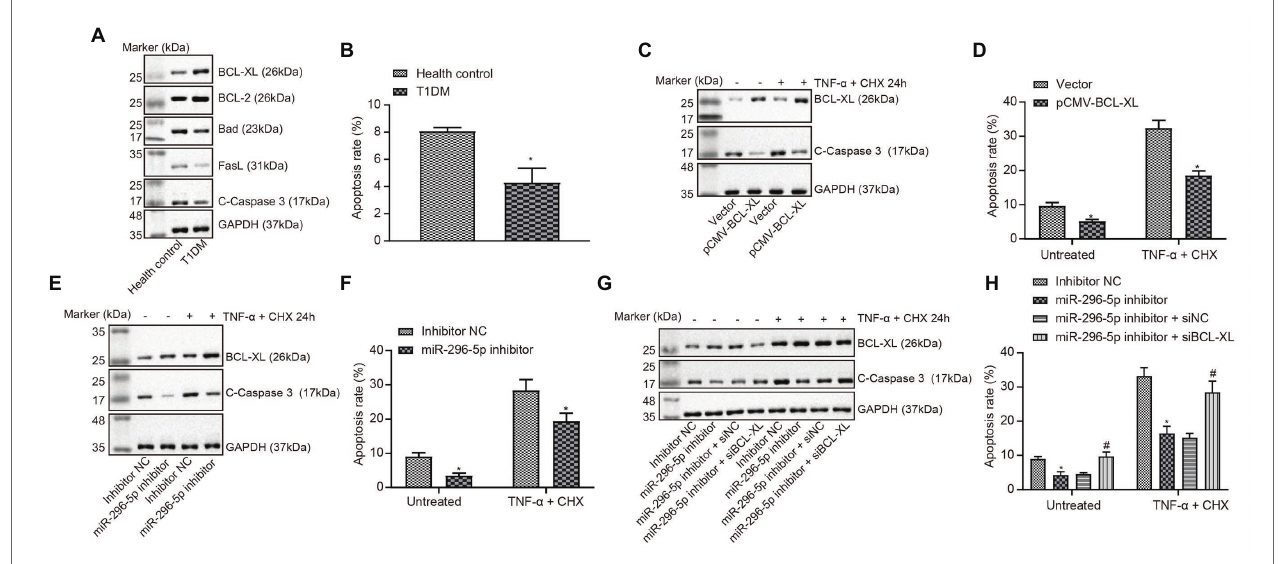
FIGURE 3 | miR-296-5p overexpression enhances lymphocyte apoptosis by targeting Bcl-xl . (A) The expression of pro-apoptotic and anti-apoptotic proteins normalized to GAPDH in PBMCs of patients with T1DM determined by Western blot assay ( n = 30). (B) Quantitative analysis of apoptosis of PBMCs in patients with T1DM compared with healthy individuals analyzed using flow cytometry. (C) The protein expression of BCL-XL and C-caspase3 normalized to GAPDH determined by Western blot assay after lymphocytes transfected with vector and pCMV- Bcl-xl . (D) Quantitative analysis of apoptosis of lymphocytes transfected with vector and pCMV- Bcl-xl analyzed using flow cytometry. (E) The protein expression of BCL-XL and C-caspase3 normalized to GAPDH determined by Western blot assay after lymphocytes transfected with miR-296-5p inhibitor or inhibitor NC. (F) Quantitative analysis of apoptosis of lymphocytes after transfected with miR-296-5p inhibitor or inhibitor NC evaluated by flow cytometry. (G) Rescue experiments on the protein expression of BCL-XL and C-caspase3 normalized to GAPDH determined by Western blot assay. (H) Rescue experiments on the apoptosis of lymphocytes evaluated by flow cytometry. * p < 0.05 compared with cells transfected with control, vector, or inhibitor NC, # p < 0.05 compared with cells transfected with miR-296 inhibitor + si-NC. The results were measurement data and expressed as mean ± standard deviation. Data comparison between two groups was performed using unpaired sample t -test, and data comparisons among multiple groups were performed using one-way analysis of variance. The cell experiment was repeated three times